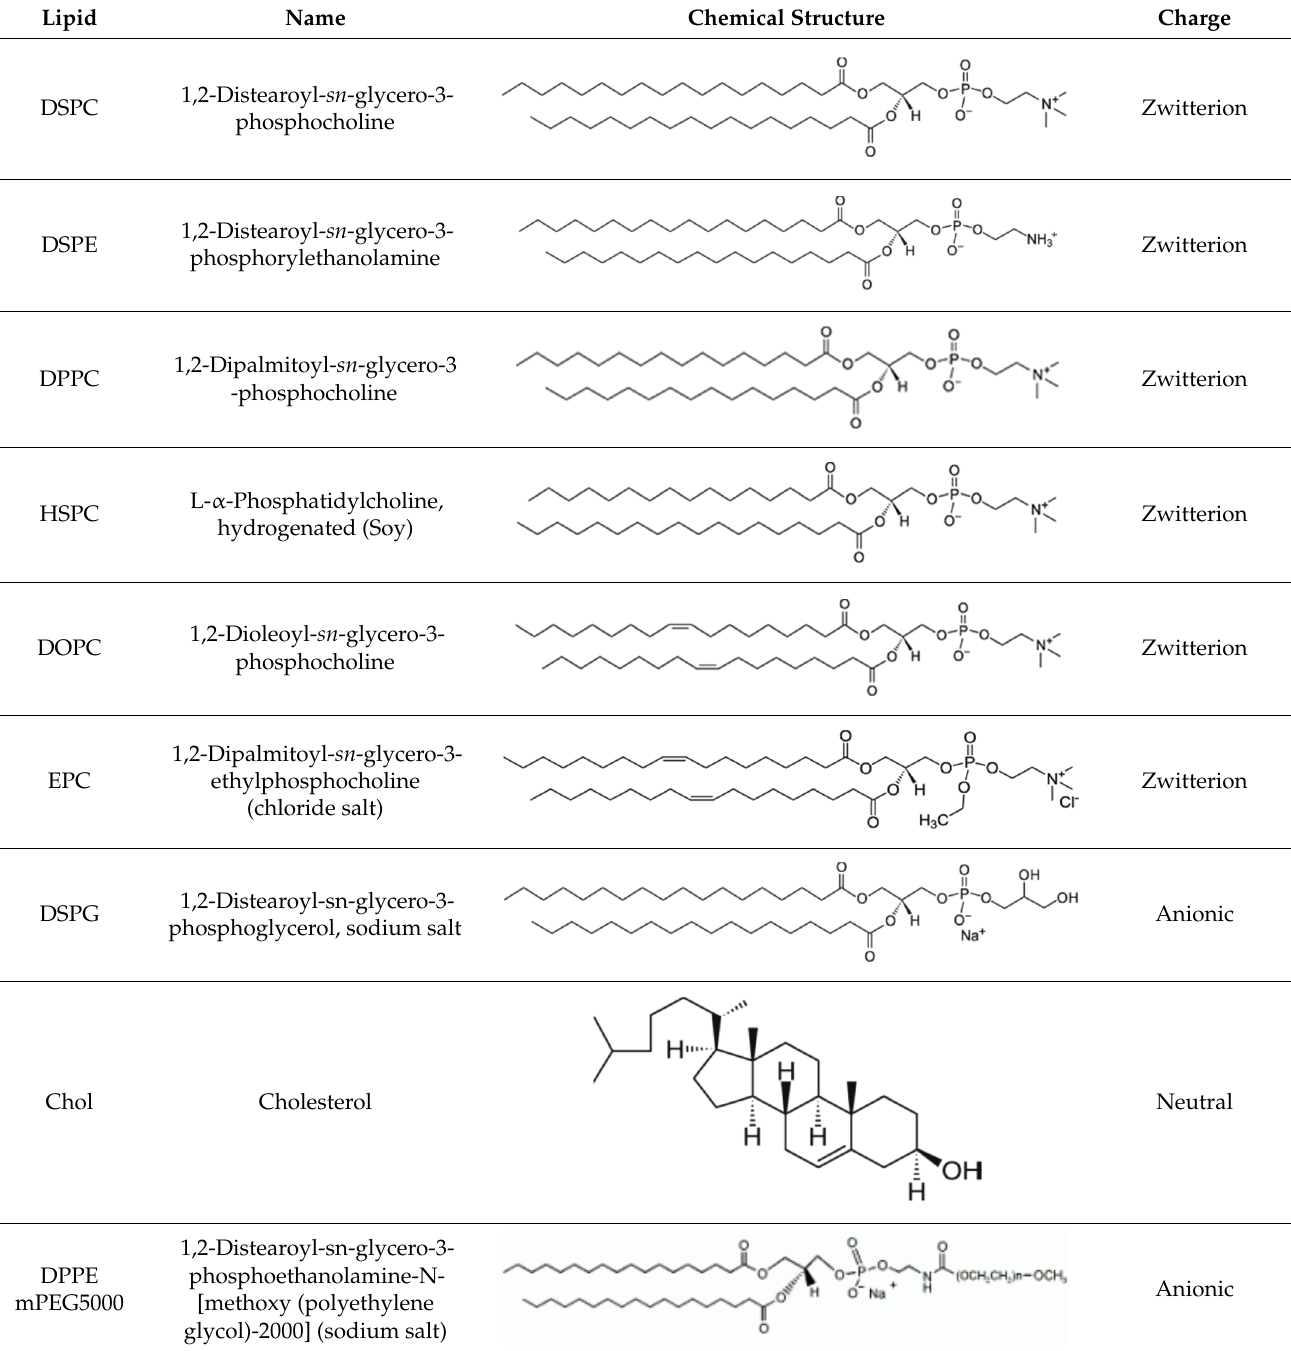
Table 1. Chemical structure and charge of the most common lipids used in liposomal formulations.